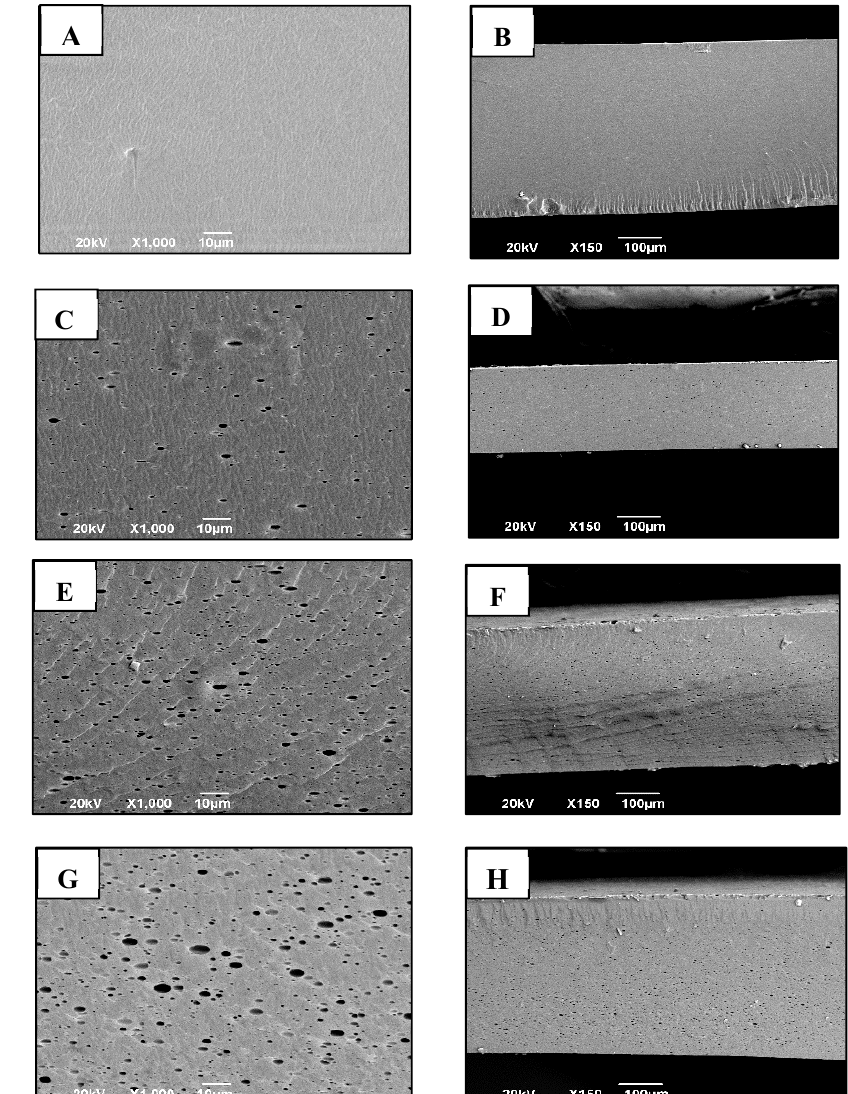
Figure 1. Cross-section analysis of CT-TCEO films with 0% ( A ) and ( B ), 0.5% ( C ) and ( D ), 1.0% ( E ) and ( F ), and 1.5% ( G ) and ( H ), at ×1000 and ×150 of magnification, respectively.